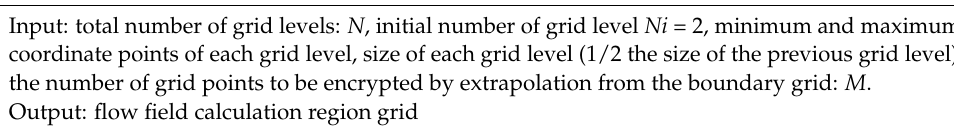
Algorithm 2 Multi-level grid generation